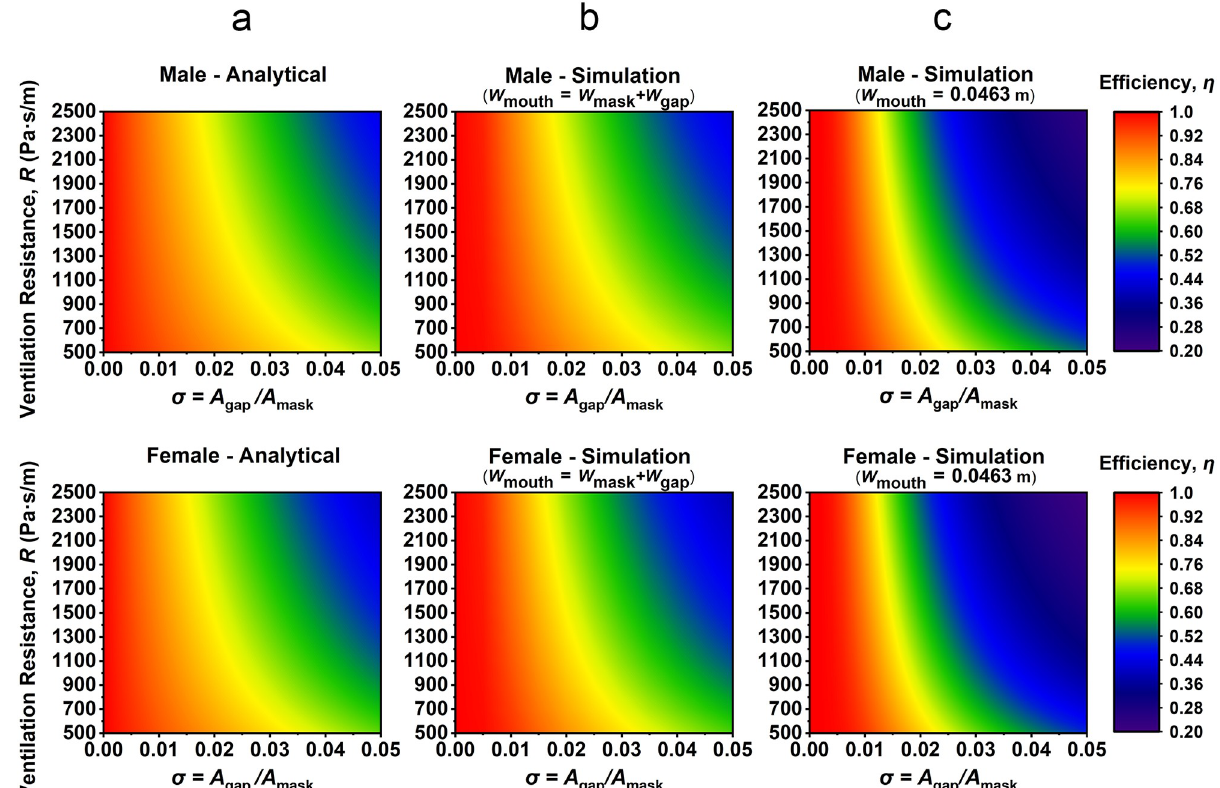
Fig 5. The relationships between σ , R, and η of different sex. (a) Analytical result, (b) simulation result with mouth inlet/outlet extending the width of the simulation domain ( W mouth = W mask + W gap ), and (c) simulation result with a finite mouth width ( W mouth = 0.0463 m).